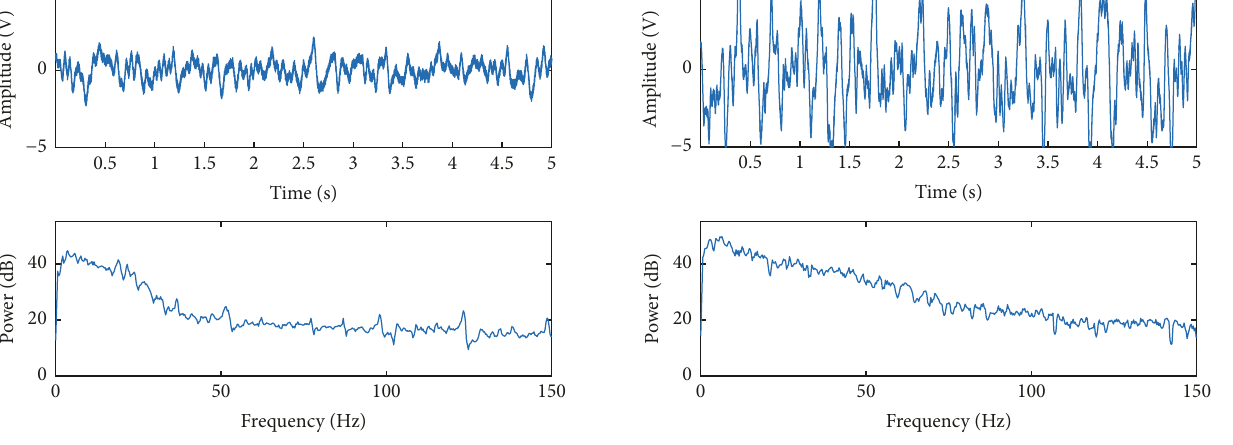
Figure 14: Received signal and power spectrum when the trans- ducer frequency is 20 Hz and flow meter value is 0.36 m/s.